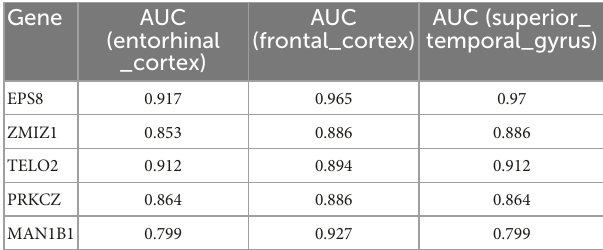
TABLE 1 The five genes, which have been validated by Alzheimer’s mice model, show high ability to discriminate patients with AD and healthy